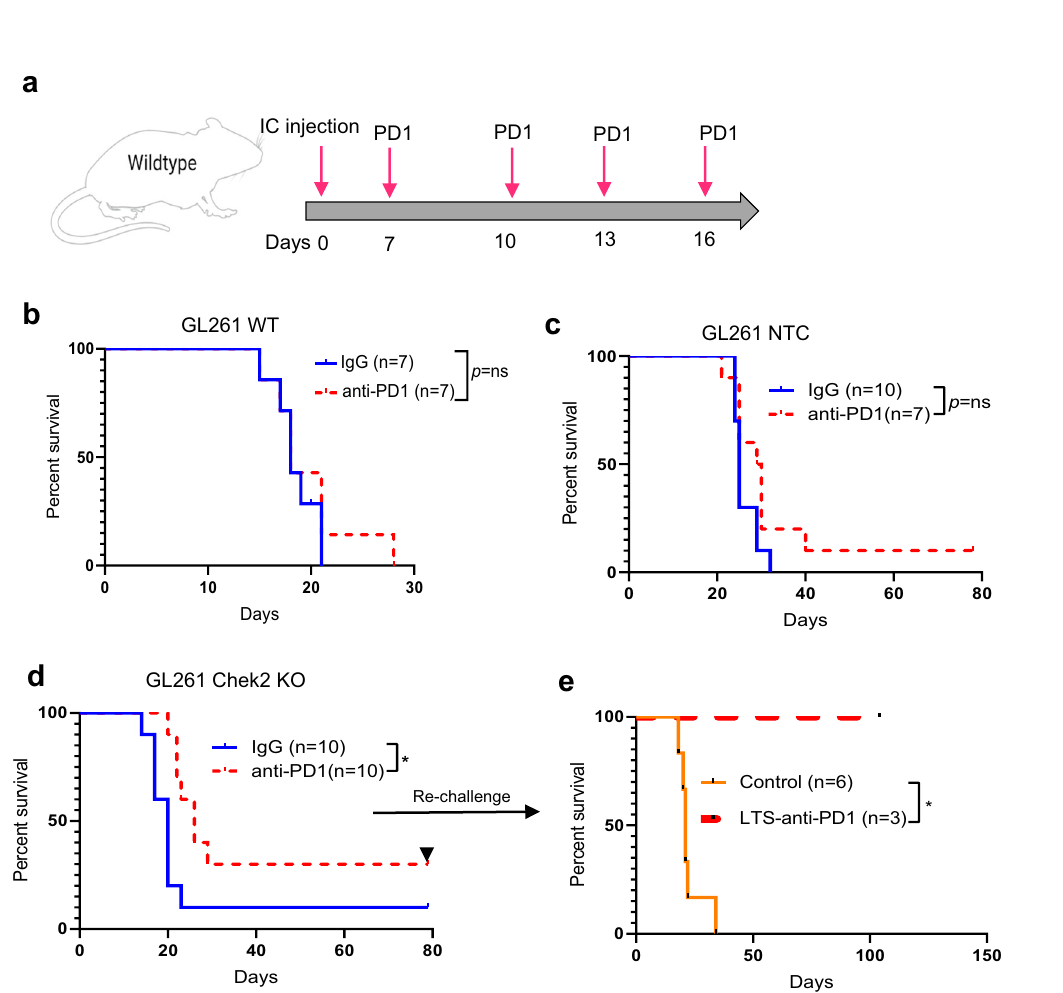
Fig. 6 | Chek2 depleted gliomas show improved response to PD-1